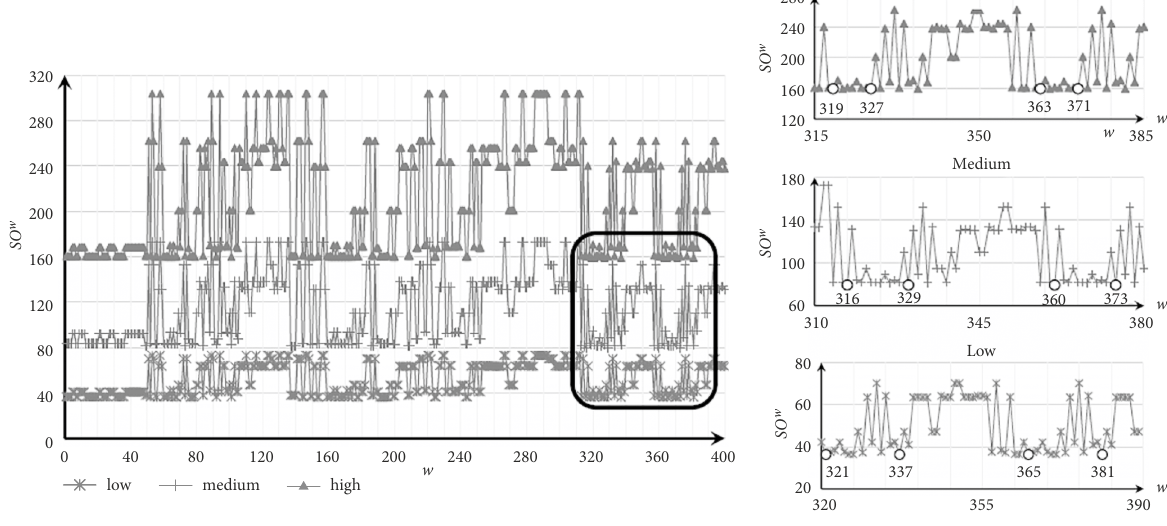
Figure 7. Optimization result of the proposal method Table 8. Phase structure of conventional signal control